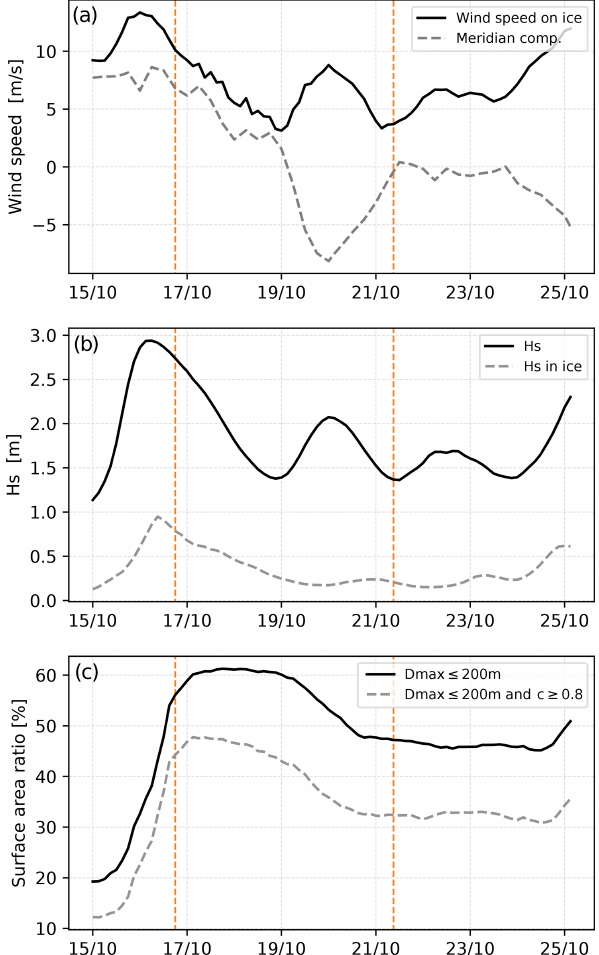
Figure 9. Temporal evolution of (a) the wind speed (black solid line) and its meridional component (dashed grey line) averaged over the entire ice-covered part of the domain (see Fig. 8 for the domain definition), (b) the significant wave height averaged over the en- tire domain (black solid line) and ice-covered part of the domain only (dashed grey line) and (c) the ratio of the surface area of re- gions covered by recently broken sea ice (defined as D max ≤ 200m, black solid line) and compact sea ice that has been recently broken (defined as D max ≤ 200m and c ≥ 0 . 8, grey dashed line) over the total sea ice-covered surface area. The time period shown covers 15–25 October 2015, for which initial conditions are given in Fig. 8. The sea ice-covered part of the domain is the area for which the sea ice concentration c is greater than 0. The two orange vertical lines indicate the dates of the snapshots shown in Figs. 10, 11 and